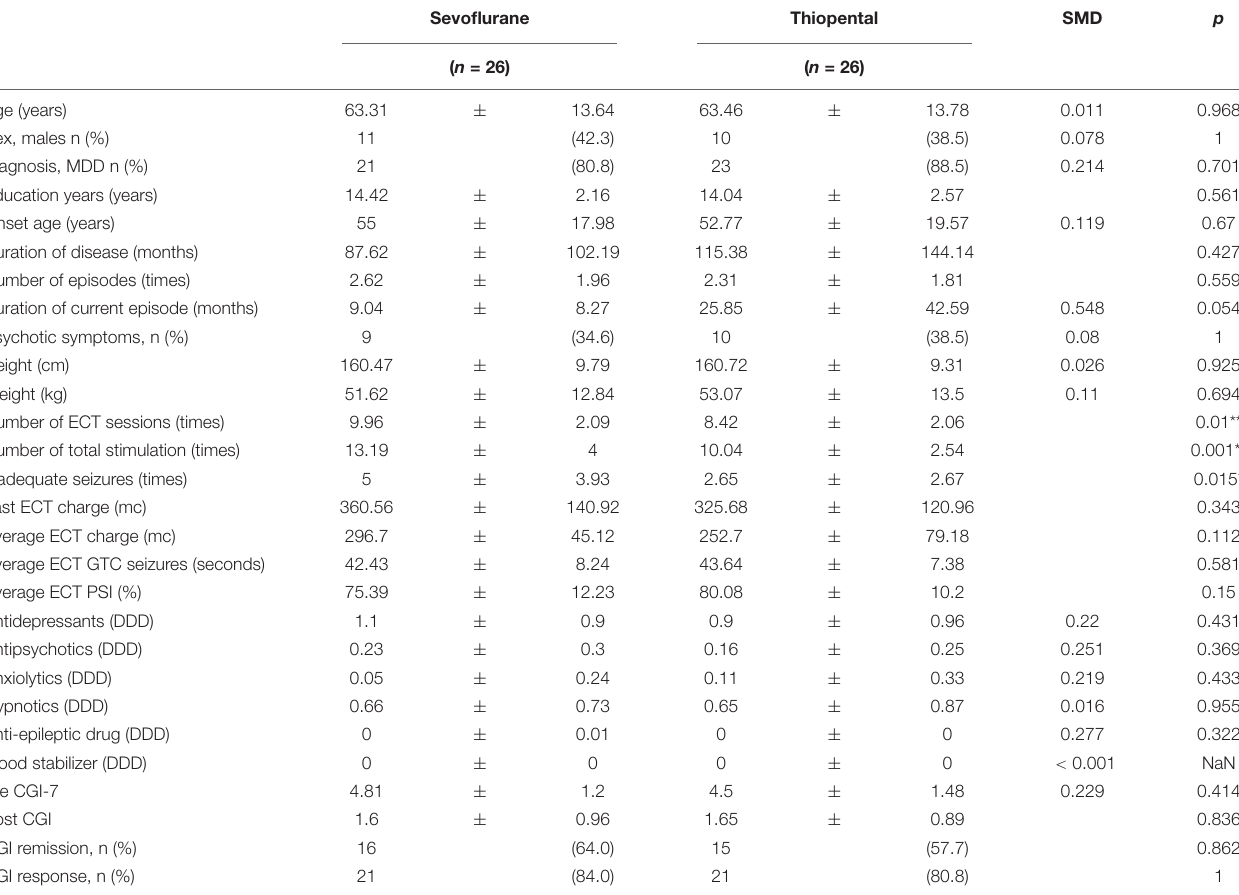
TABLE 2 | Participant characteristics after propensity score matching.